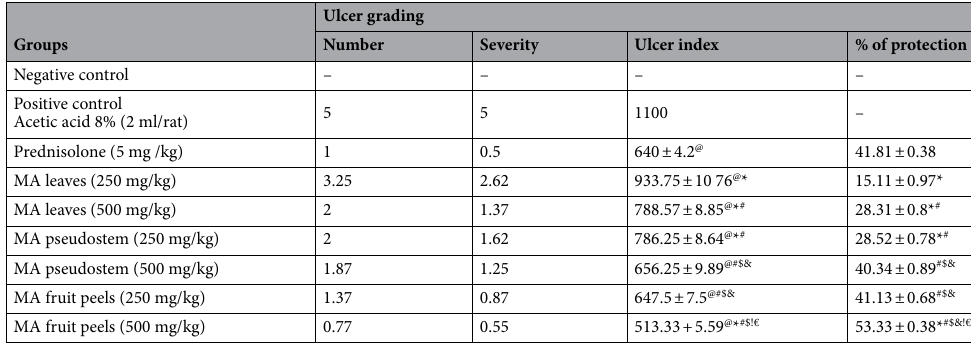
Table 4. Macroscopic grading of the protective effect of oral administration of MA leaves, pseudostem and fruit peels extracts on colonic ulceration. Results are expressed as means of ulcer number, severity, index and % of treatment protective effect ± SE after 14 days of MA extract and prednisolone administration. followed by ulcer induction by single pr acetic acid infusion. n = 8; Data were analysed using one way analysis of variance (ANOVA) followed by Tukey Kramer’s multiple comparison test; Significance was considered at P ≤ 0.05. @ Significantly different from positive control group, *significantly different from prednisolone group, # significantly different from MA leaves 250 mg/kg group, $ significantly different from MA leaves 500 mg/ kg group, & significantly different from MA pseudostem 250 mg/kg group, ! significantly different from MA pseudostem 500 mg/kg group, € significantly different from MA fruit peels 250 mg/kg group.